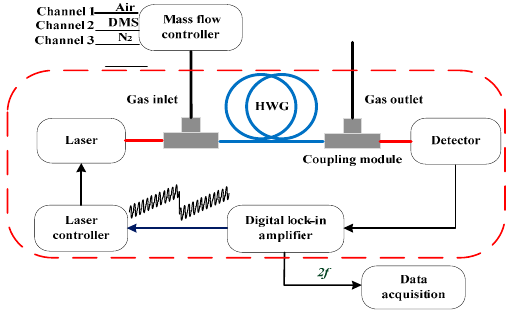
Figure 2. Experimental block diagram.